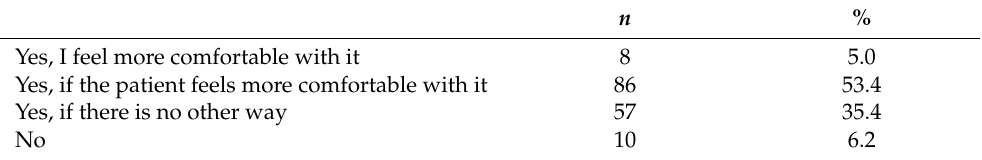
Table 7. Psychotherapists’ intention to use remote psychotherapy until the end of the COVID-19 pandemic.